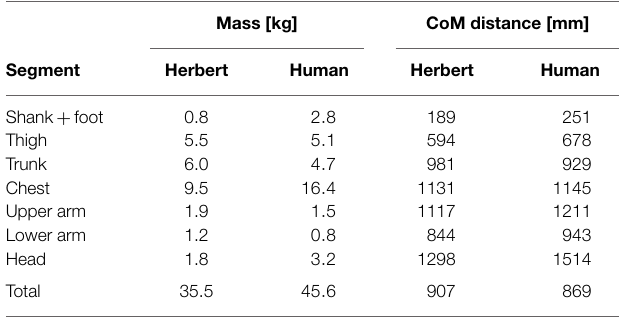
TABLE 1 | The mass of each segment of Herbert compared to a human and the distance from the sole to the center of mass of each segment . Mass [kg] CoM distance [mm]